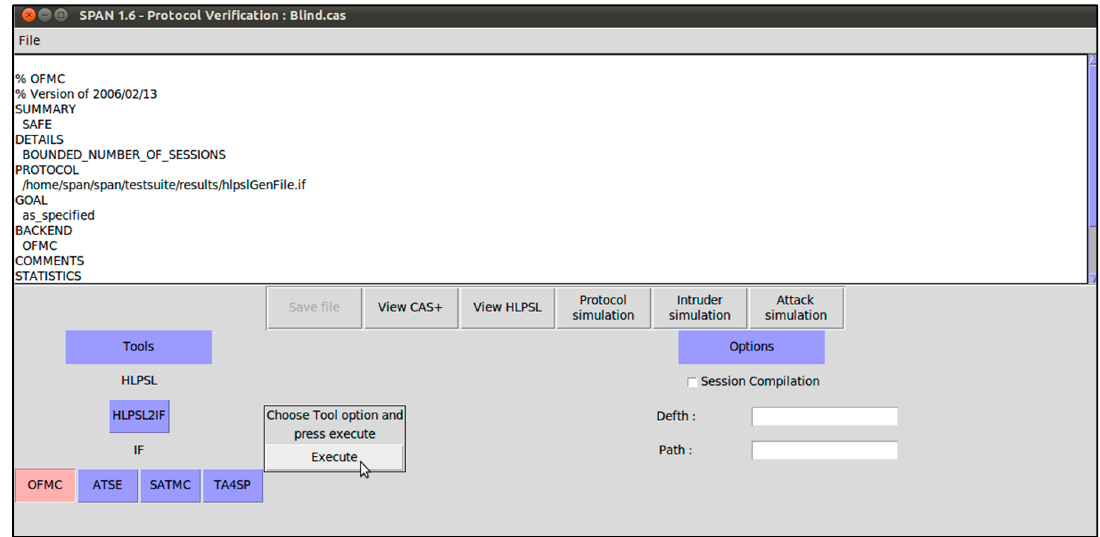
Figure A1. Simulation results for on-the-fly model-checker (OFMC).